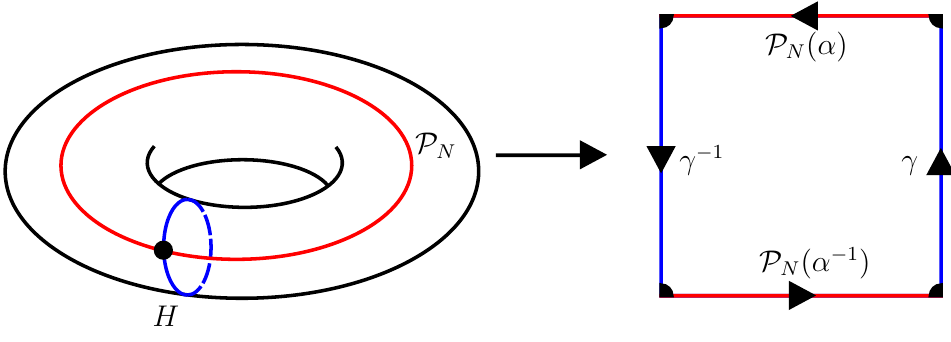
Figure 5 . TFT2 partition function for finite N weak coupling BPS